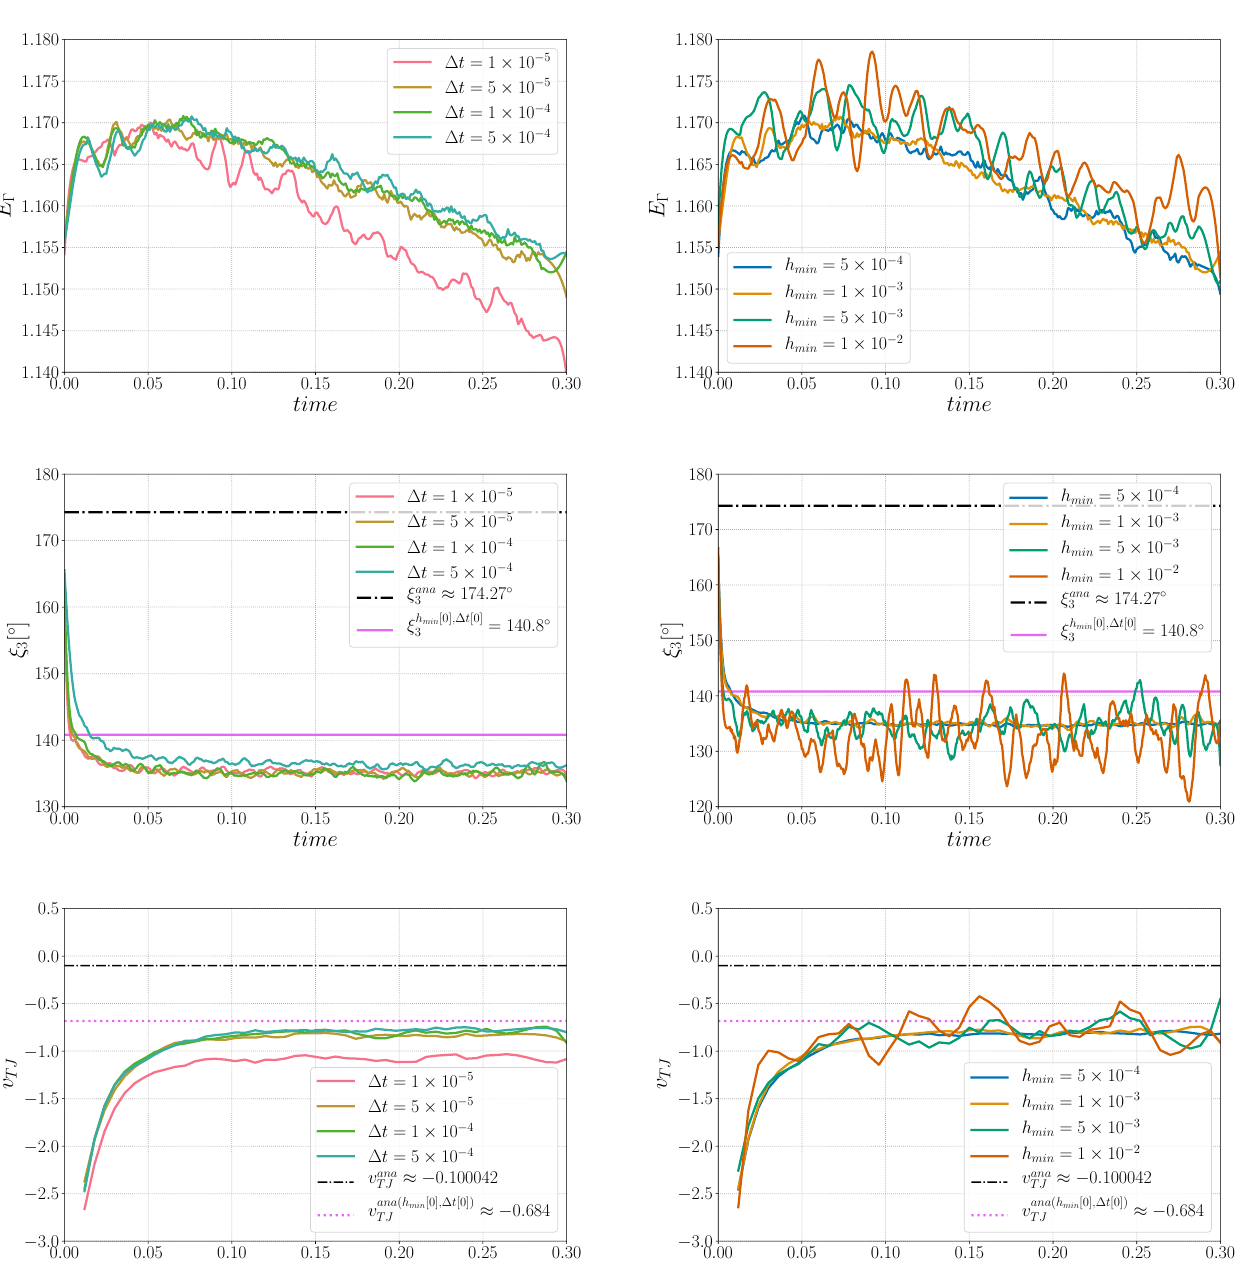
10 − 3 and in ( right ) h min size for ×